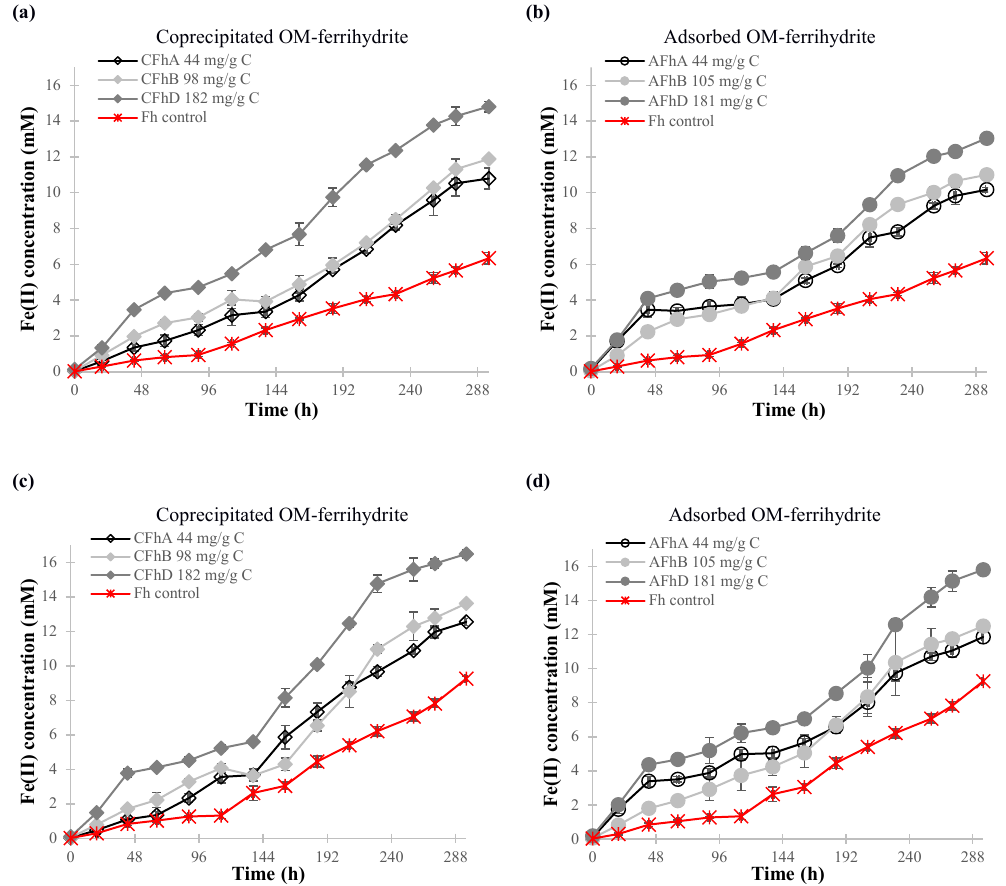
Figure 1. Microbial reduction of ferrihydrite and OM–ferrihydrite complexes by Shewanella oneidensis MR-1 and a microbial consortia extracted from peatland. Panels (a) and (b) depict S. oneidensis MR-1-mediated reduction of ferrihydrite (Fh control) and either coprecipi- tated OM–ferrihydrite (CFh) or adsorbed OM–ferrihydrite (AFh). Panels (c) and (d) depict reduction of ferrihydrite (Fh control) and either coprecipitated OM–ferrihydrite (CFh) or adsorbed OM–ferrihydrite (AFh) in incubations with a microbial consortia extracted from peatland. Error bars represent standard deviation in triplicate